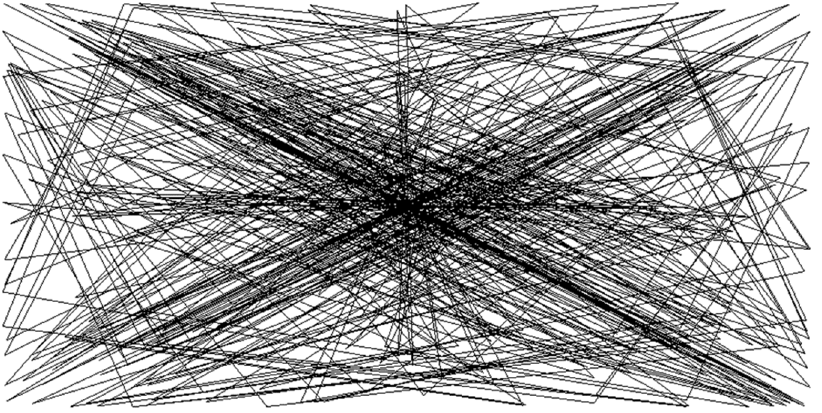
Figure 6. Trajectory of the particle in a two-dimensional chaotic model for the value of parameter, p